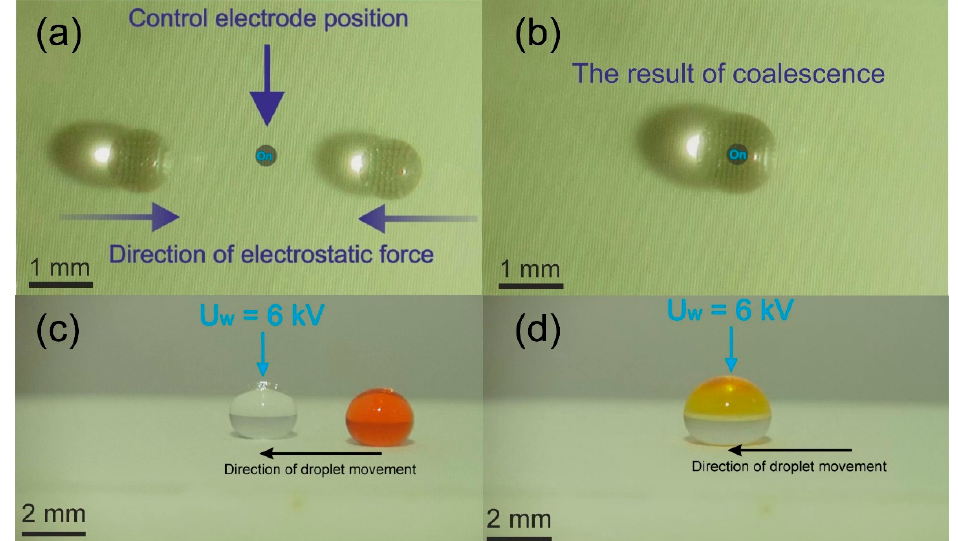
Figure 5. Coalescence of droplets on PMD. Coalescence of the first type ( a , b ); starting position of two deionized water droplets ( a ) and result of the coalescence ( b ). Coalescence of second type ( c , d ); droplet of methyl orange moves to motionless droplet of alkali ( c ) and the result of their coalescence ( d ).